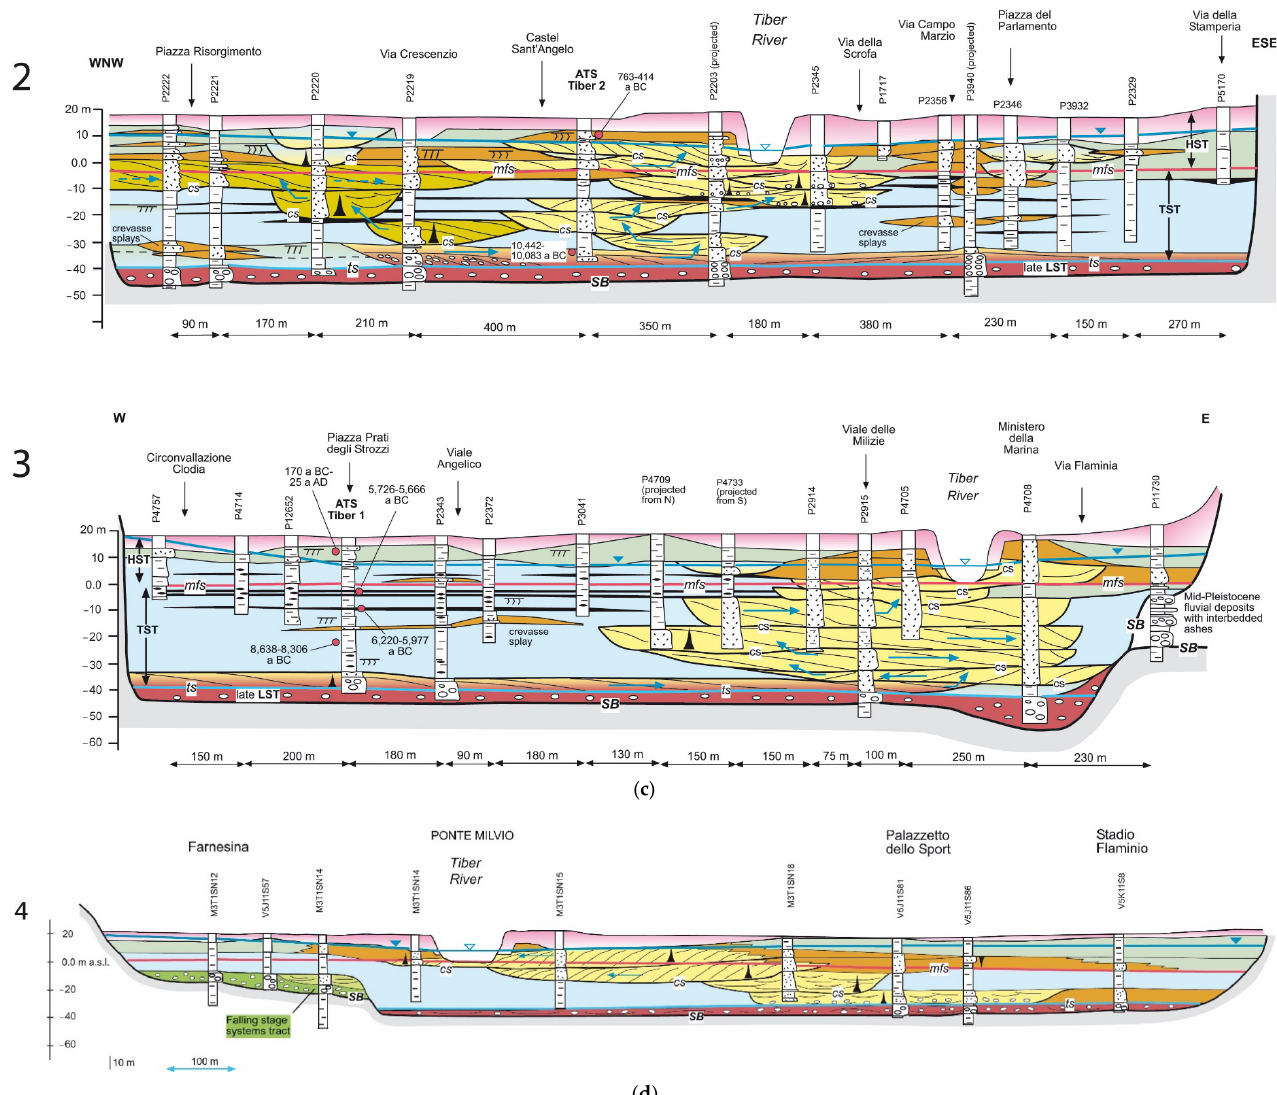
Figure 2. ( a ) Geological map of the study area, location of S1-S2-S3 boreholes, and trace of cross sections of Figure 2b, c and d. The basal surface of Tiber River depositional sequence is also mapped (contour lines every 10 m). Reference system: WGS 84/UTM zone 33N. ( b ) Cross section 1 (Piazza Pia- Piazza Venezia) through the Tiber River depositional sequence (after [25]). Groundwater level data are from monitored boreholes and literature data ([37]). ( c ) Cross Sections 2 and 3 through the Tiber River depositional sequence: 2: Piazza Risorgimento- Fontana di Trevi. 3: Prati-Flaminio. ( d ) Cross Section 4: Farnesina-Stadio Flaminio. Traces in Figure 2a; legend in Figure 2b.